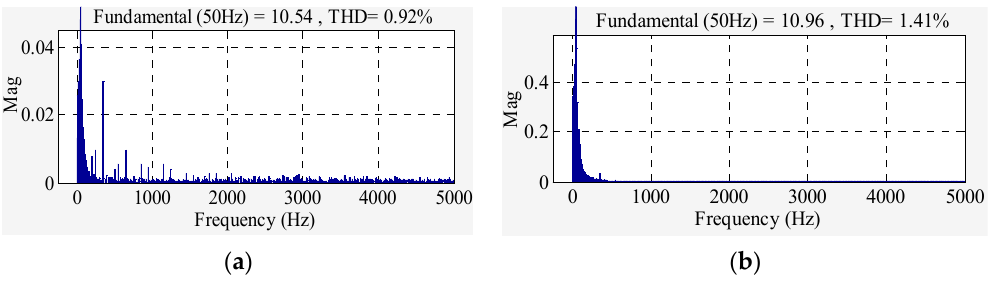
Figure 10. FFT analysis of the source current after compensation obtained from SAPF ( a ) with FLC and ( b ) without FLC.